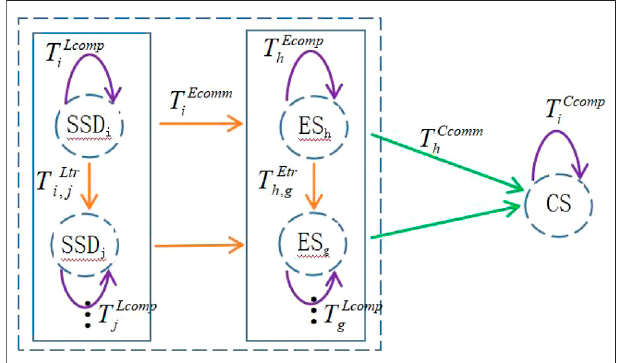
FIGURE 3 | Schematic diagram of the scheduling time. And execution time of task Qi on SSDi in the